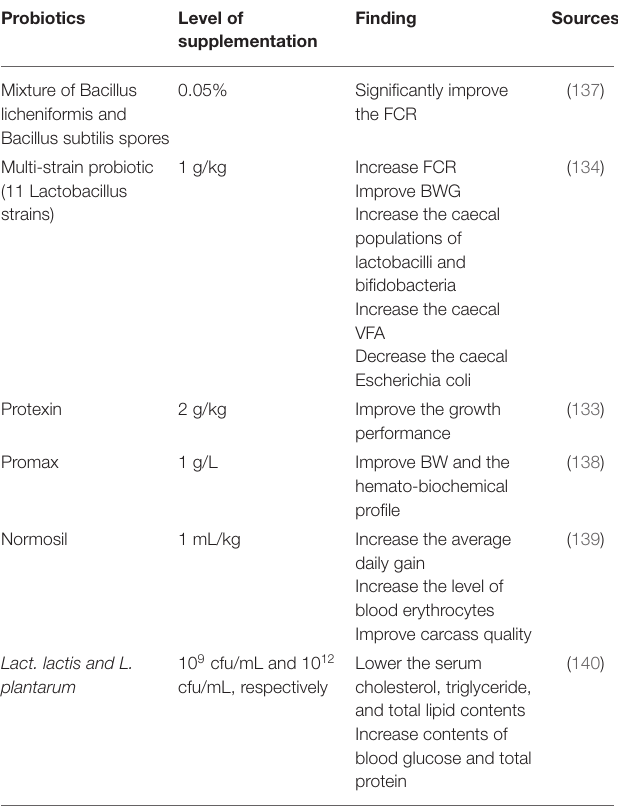
TABLE 4 | Probiotics and their ameliorative effects on broiler production.